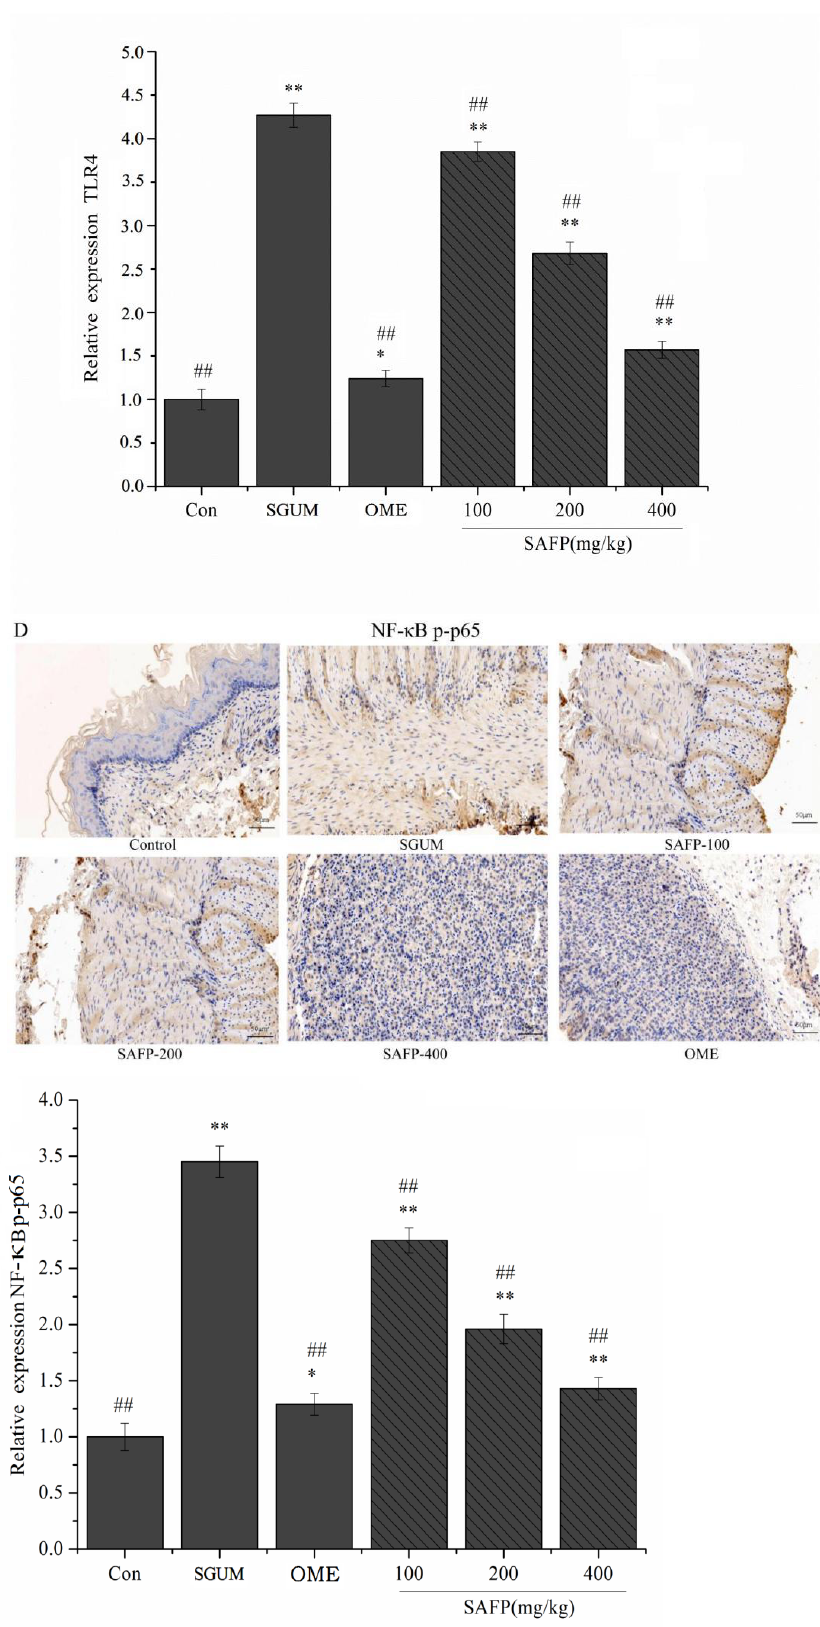
Figure 5. Immunohistochemical assay. ( A ) Expression of Keap-1 by immunohistochemical staining and statistical analysis of Keap-1. ( B ) Expression of Nrf2 by immunohistochemical staining and sta- tistical analysis of Nrf2. ( C ) Expression of TLR4 by immunohistochemical staining and statistical analysis of TLR4. ( D ) Expression of NF-κBp-p65 by immunohistochemical staining and statistical analysis of NF-κBp-p65. Data are represented by mean ± SD ( n = 10). * p < 0.05, ** p < 0.01 vs. control group. # p < 0.05, ## p < 0.01, vs. SGUM group.